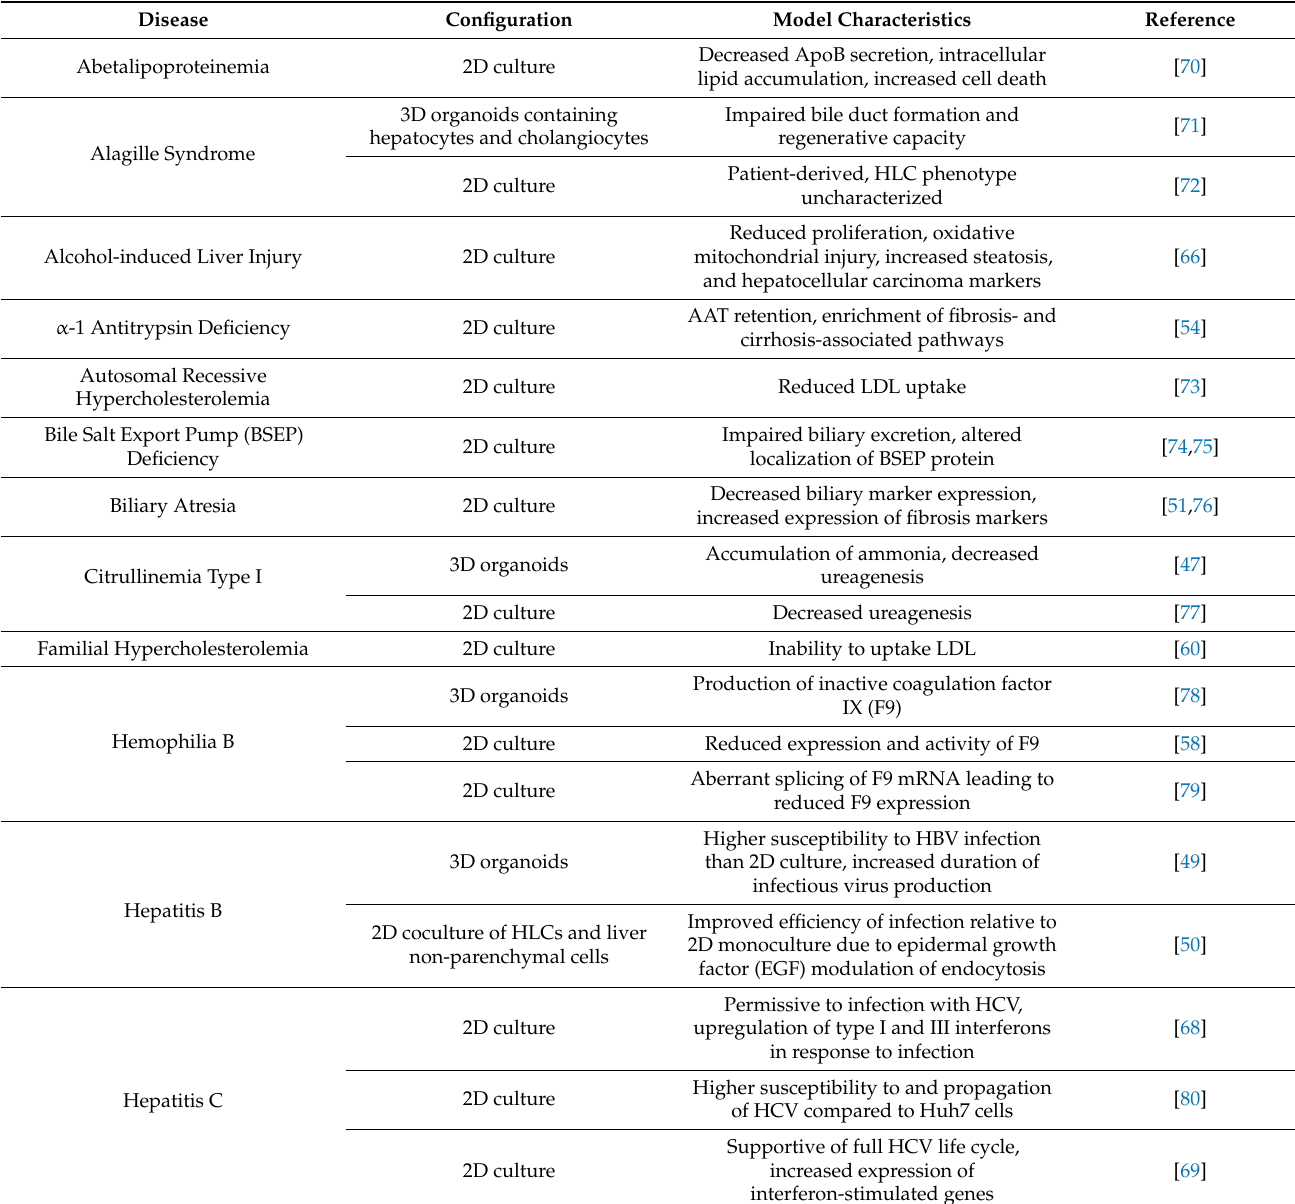
Table 1. Liver Diseases Modeled by iPSC-based